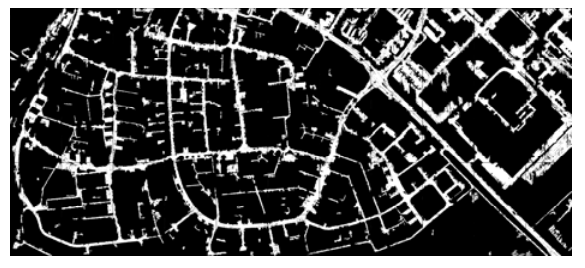
Figure 6. Road extraction